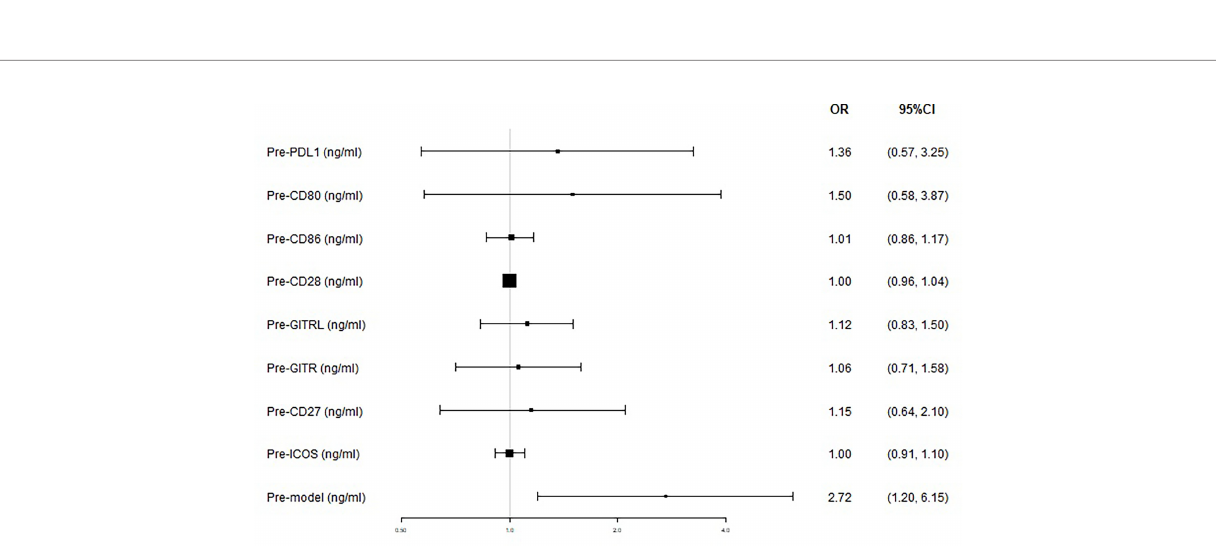
FIGURE 4 | The receiver operating characteristic (ROC) curves analysis for the sensitivity and speci fi city of TRG classi fi cation. The ROC curve of sPD-L1, sCD80, sCD86, sCD28, sGITR, sGITRL, sCD27, sICOS, and the combined markers before (A) , during (B) , and after nCRT (C) were plotted. AUC (area under the curve) is in the left